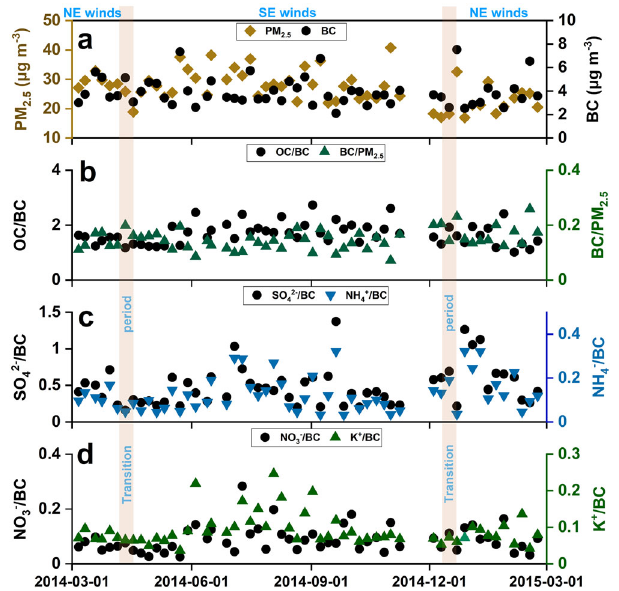
Fig. 2 Year-round variation of PM 2.5, BC, and source-diagnostic ratios. a Shows PM 2.5 and BC concentrations, b shows OC/BC and BC/PM 2.5 ratios, c shows SO 4 2 − /BC and NH 4 + /BC ratios and d presents K + /BC and NO 3 − / BC ratios. The predominant air masses arriving at Nairobi are marked out on top, and the transition periods are highlighted in light brown colour.